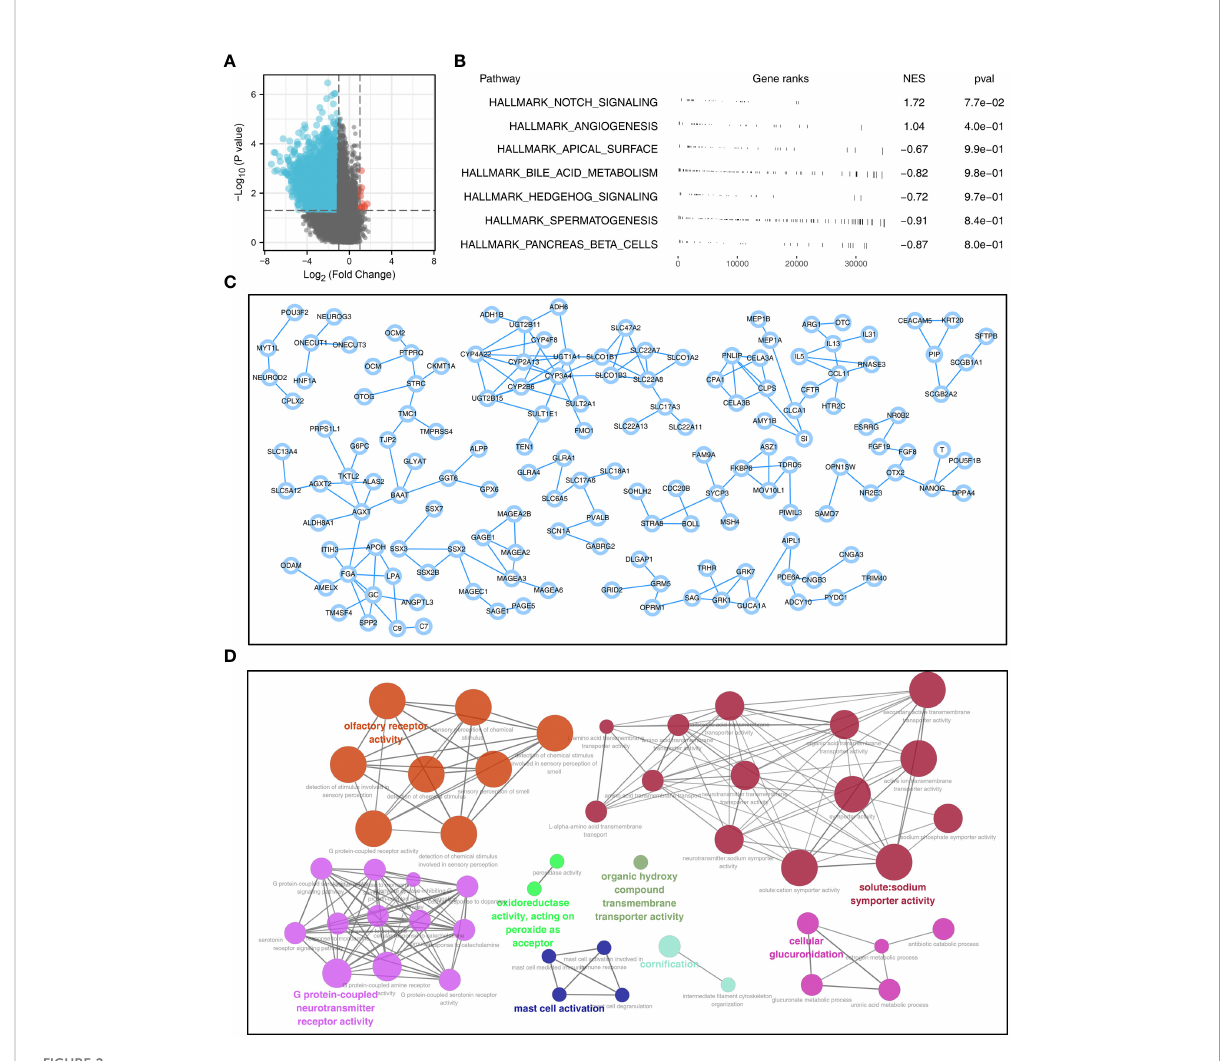
FIGURE 2 PPI network and pathway enrichment analysis of sphingolipid metabolism (A) : With the threshold of |logFC| > 1 and P < 0.05, 5969 downregulated and 11 upregulated genes were identi fi ed between patients with high and low sphingolipid metabolism activity; (B) : GSEA analysis was performed based on the Hallmark gene set to explore the biological differences between high and low sphingolipid metabolism patients; (C) : PPI network based on the DEGs was established to reveal potential protein interactions; (D) : ClueGO (a plug-in in Cytoscape software) analysis of the